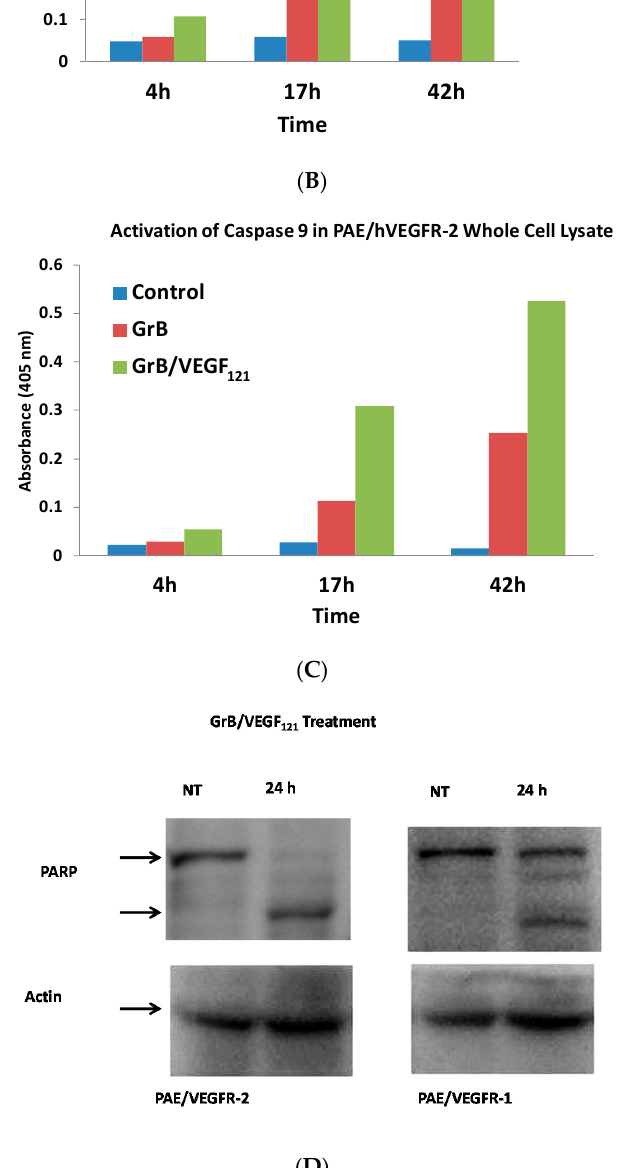
Figure 5. GrB/VEGF 121 triggers mitochondrial depolarization and caspase activation in target cells, resulting in PARP-1 cleavage. ( A ) GrB/VEGF 121 selectively triggered mitochondrial depolarization over 48 h selectively in VEGFR-2-overexpressing endothelial cells. ( B ) Using a Caspase-3 chromogenic substrate, Caspase-3 activation was also observed, as was ( C ) activation of Caspase-9 with the appropriate chromogenic substrate. ( D ) PARP cleavage was more robust and complete in VEGFR-2-overexpressing endothelial cells, compared to VEGFR-1-overexpressing endothelial